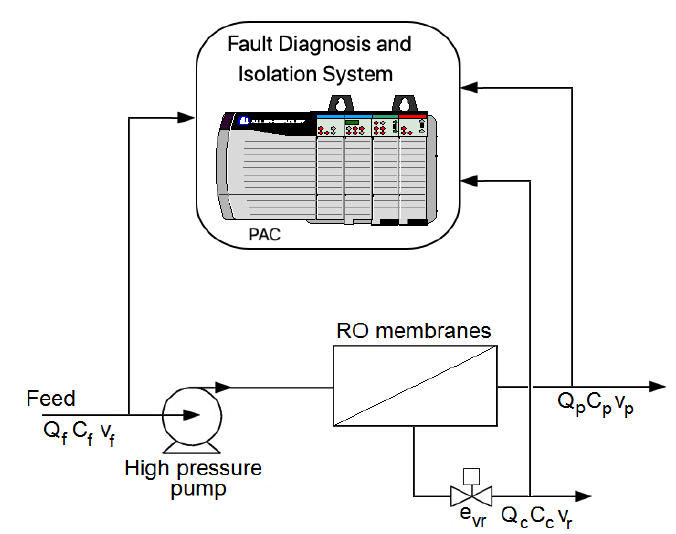
Figure 10. FDI system